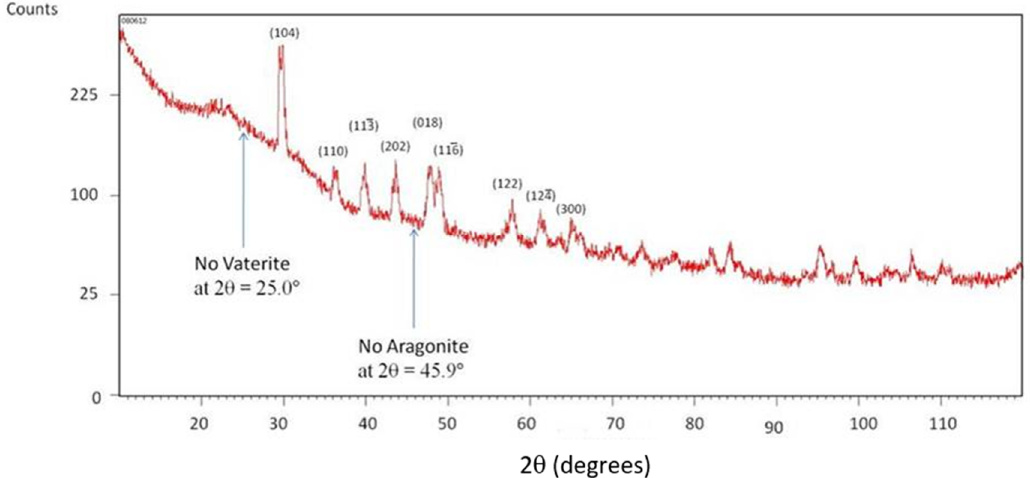
Figure 6. X-ray diffraction (XRD) analysis of the CaCO 3 shells of liposome-derived microcapsules. The XRD pattern display peaks characteristic of calcite. The theta values are slightly larger than expected for pure calcite due to magnesium ion incorporation (which is smaller than calcium ion, and thus reduces the lattice dimensions). The mineral coating does not contain significant amounts of vaterite or aragonite, as evidenced by the absence of peaks at their characteristic high intensity locations of 2 θ = 25.0° and 45.9°, respectively.